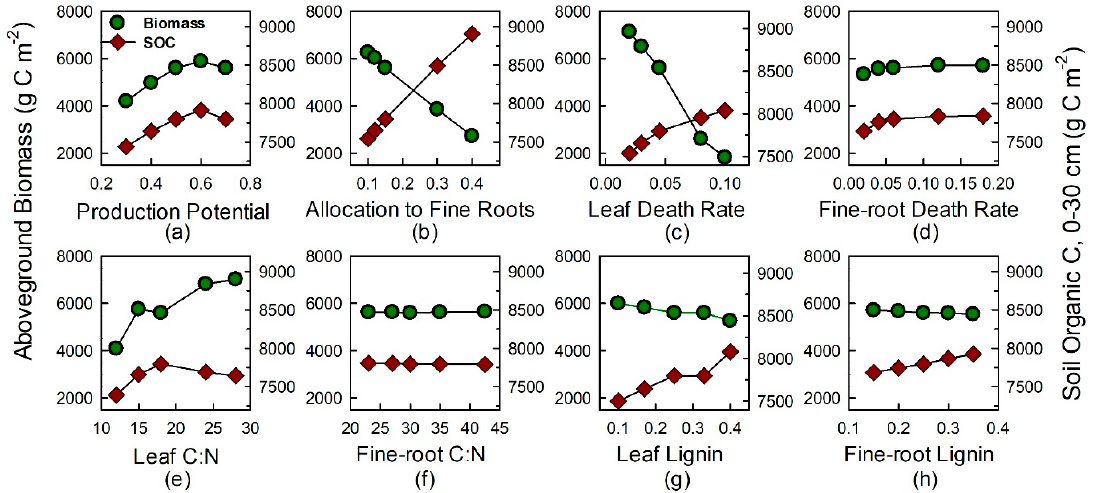
Figure 4. Sensitivity analyses to evaluate effects of traits of tree species on aboveground biomass and soil organic C. Plant traits included: ( a ) production potential; ( b ) allocation to fine roots; ( c , d ) leaf and fine-root death rate; ( e , f ) leaf and fine-root C:N; and ( g , h ) lignin content. The middle value corresponds to input data for ‘LSM’, La Selva mature forest.